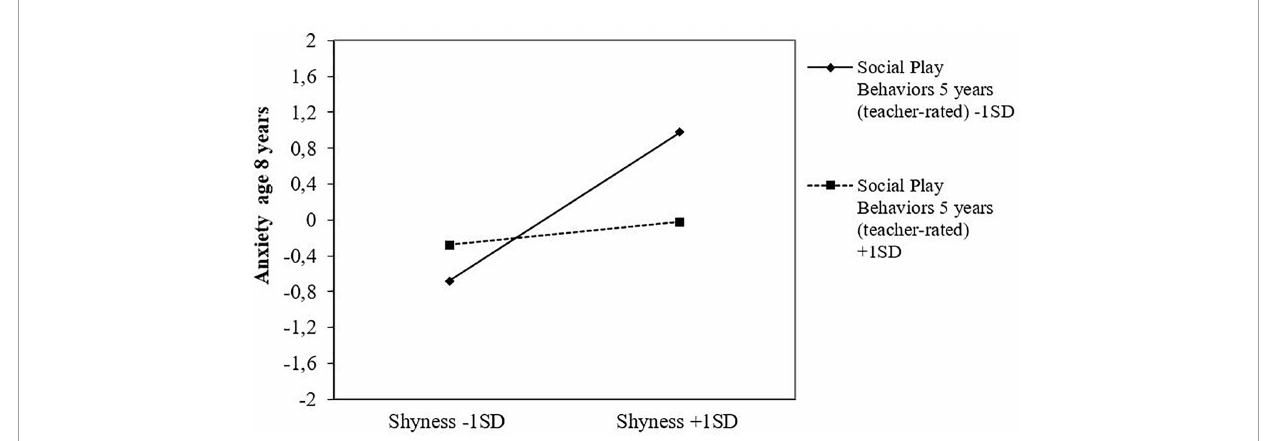
FIGURE1 Social play behaviors at age 5 years as a protective factor in the association between childhood shyness and symptoms of anxiety at age 8 years, as reported in standard deviations.